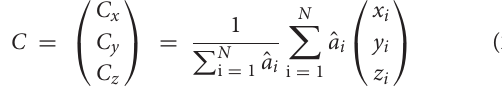
P 2 ˆ a and a k = 1 i , k being the mean value of (interpolated) i = 0 3 MEP amplitudes at the three vertices of triangle k